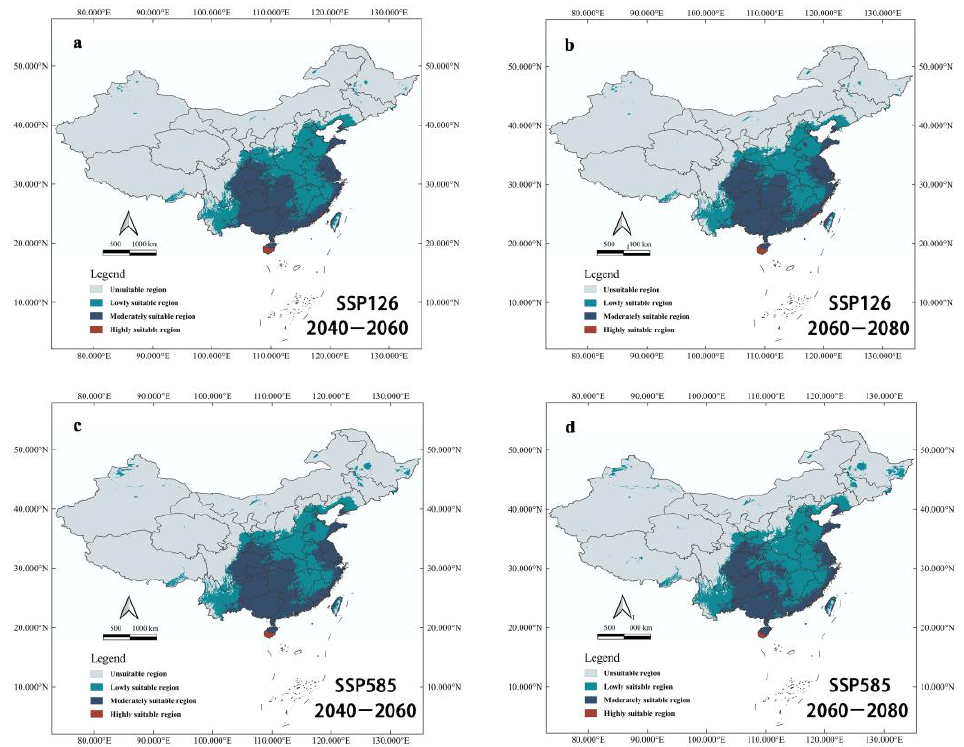
Figure 7. Habitat suitability of Ar . subalbatus under future climate change scenarios. ( a ) Potentially